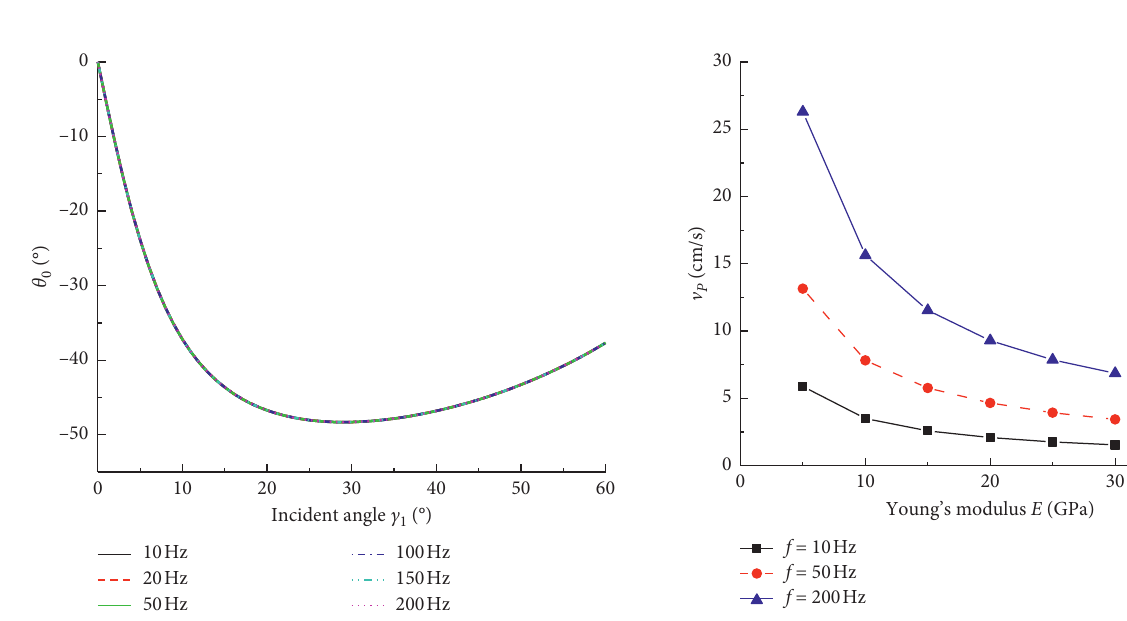
Figure 5: Variation of θ